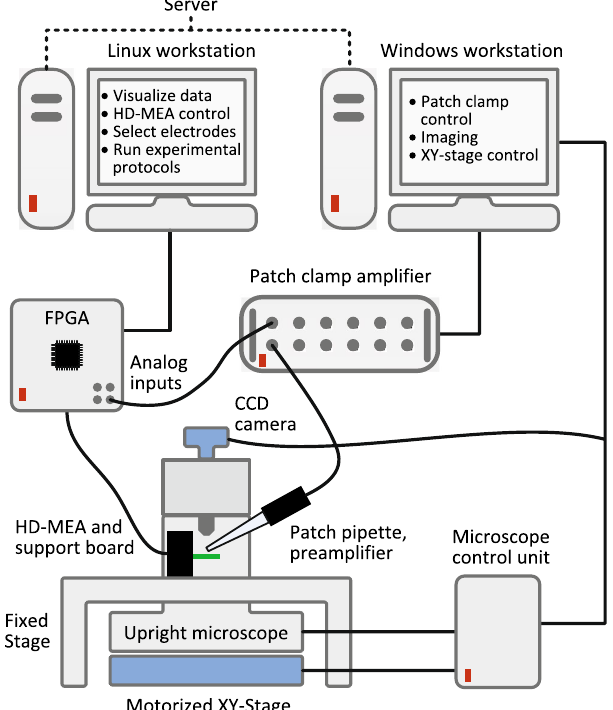
Figure 1. Experimental setup. Experimental setup consisting of a HD-MEA system, a patch clamp system, and an upright microscope. The HD-MEA is controlled through an FPGA and a Linux computer. A windows computer controls the patch-clamp amplifier settings and the microscope. The microscope is mounted on an XY-stage, which allows for determining the exact positioning for every acquired image. The Linux workstation is used to record the combined intra- and extracellular data, to visualize the data, to align acquired images to the MEA coordinates, and to run the experimental